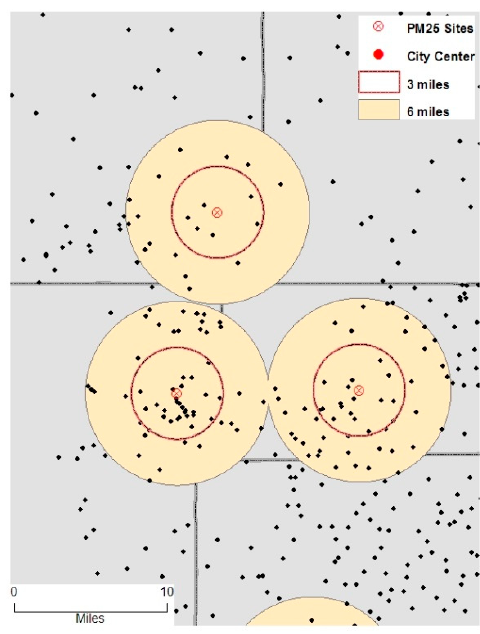
Figure 1. An example of PM 2.5 monitoring sites and inclusion of subjects within 3 and 6 mile distance radius.